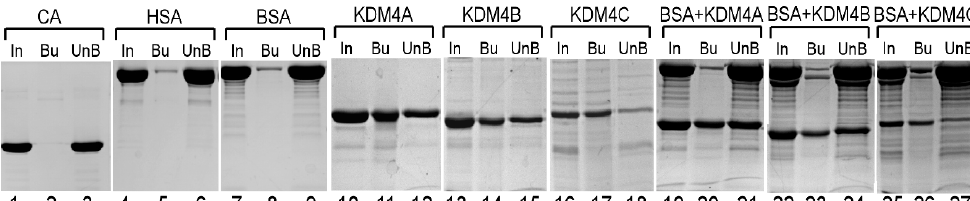
Figure 2. The pull-down of KDM4 JmjN/C domains by heme–agarose beads. Samples containing 500 pm of carbonic anhydrase (CA) (lanes 1–3), human serum albumin (HSA) (lanes 4-6), and bovine serum albumin (BSA) (lanes 7-9), and the JmjN/C domain of KDM4A (lanes 10-12), KDM4B (lanes 13- 15), or KDM4C (lanes 16-18), or a mixture of the indicated proteins (500 pm each, lines 19-27) were incubated with heme–agarose beads. The input (In), bound (Bu), and unbound proteins (UnB) were analyzed by SDS-PAGE and are shown here.